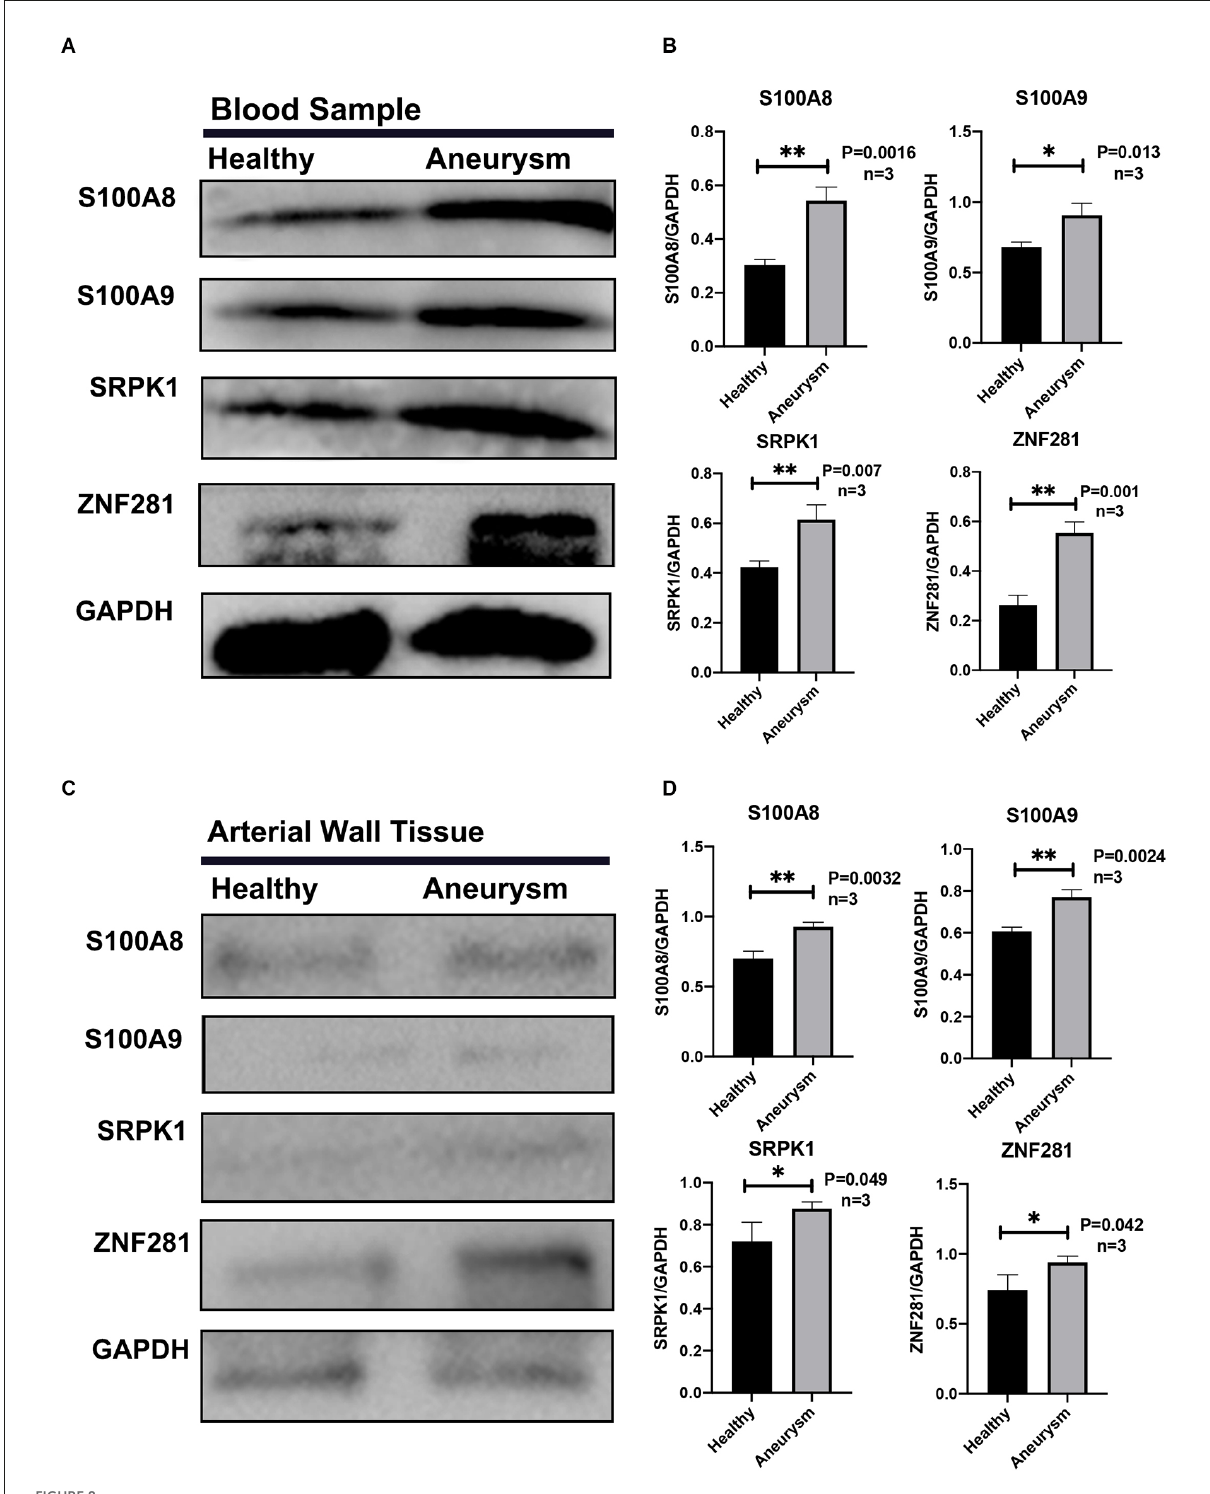
FIGURE8 (A) Representative Western blot bands of S100A8, S100A9, SRPK1, and ZNF281 expression in blood samples in different groups. (B) Quantitative analysis of S100A8, S100A9, SRPK1, and ZNF281 expression in blood samples in different groups. n = 3/group. (C) Representative Western blot bands of S100A8, S100A9, SRPK1, and ZNF281 expression in arterial walls and aneurysms walls from different groups. (D) Quantitative analysis of S100A8, S100A9, SRPK1, and ZNF281 expression in arterial samples in different groups. n = 3/group. Healthy control: Healthy middle meningeal arteries; Aneurysm: Ruptured aneurysm tissue ( ∗ p < 0.05, ∗∗ p <